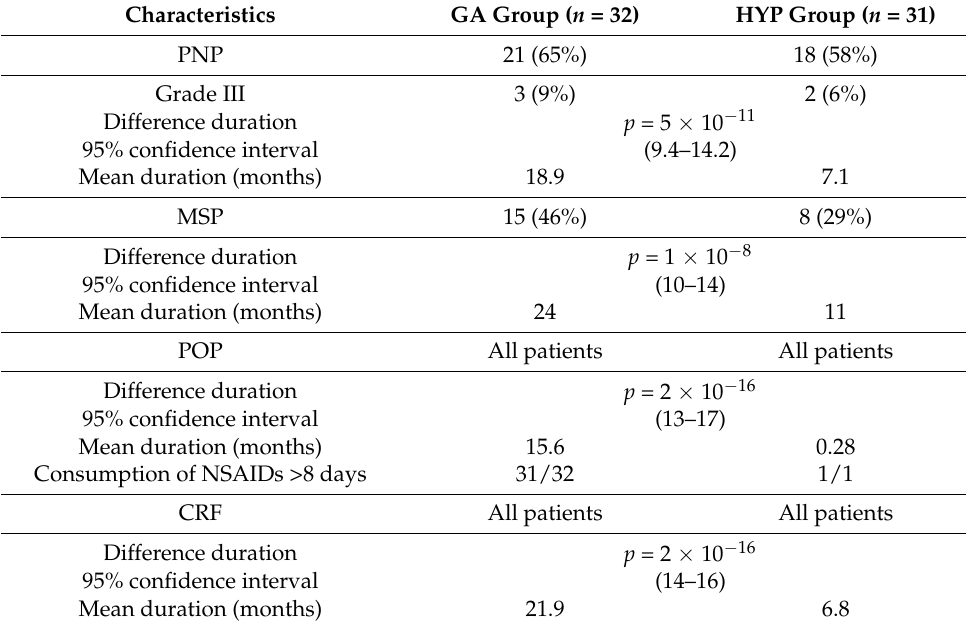
Table 3. Prevalence and difference of duration of side effects studied.